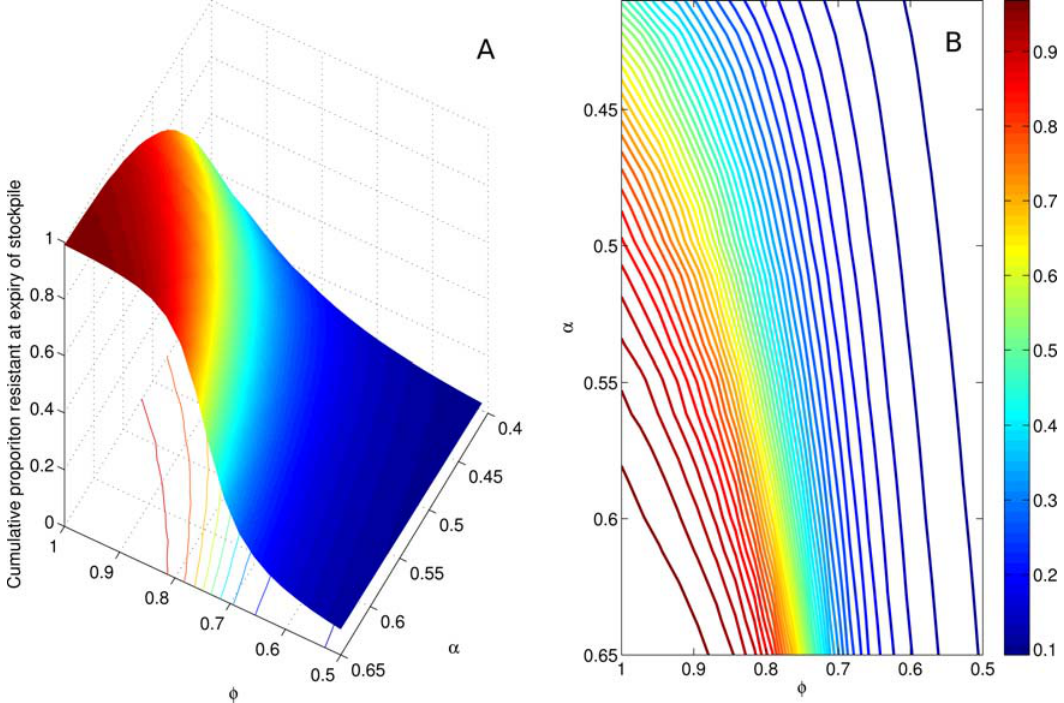
Figure 3. The proportion of cumulative infections that is resistant. a. Surface plot of the proportion of the total cumulative infections that are resistant, at the point of stockpile expiry. The transition (‘‘cliff-edge’’) from a low-transmissible to high-transmissible resistant strain occurs at w < 0.7. As a increases ( R 0 decreases) the wild-type strain is less transmissible, the intervention is more effective, and thus the resistant strain is more capable of dominating transmission. b. Contour plot as for Figure 3a.